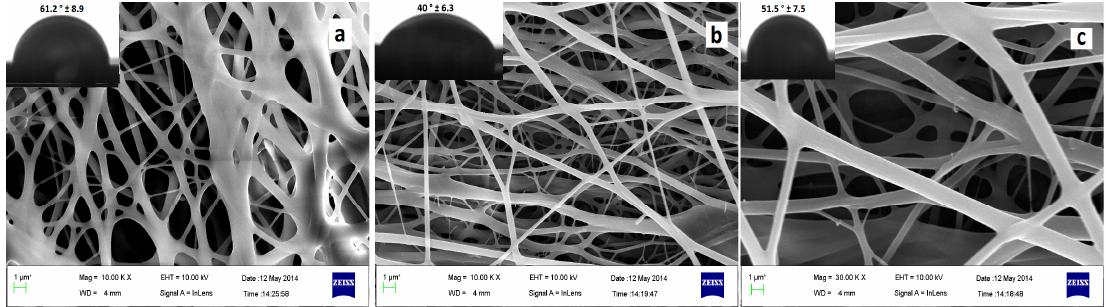
Figure 2. FESEM images illustrated surface topography of fabricated D1 nanofibers composed of ERL100/ERS100:1:3 ( a ); D2 nanofibers of ERL100/ERS100: 1:1 ( b ) and D3 nanofibers prepared from ERL100/ERS100: 3:1 ( c ).